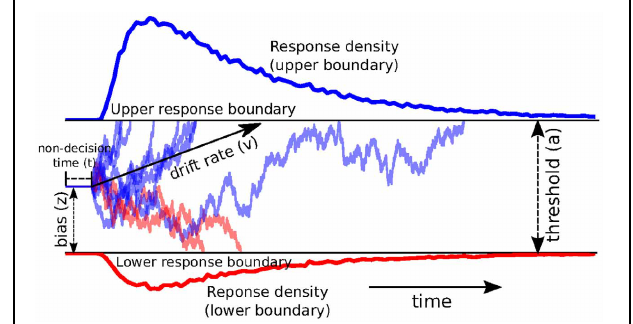
FIGURE 1 | Trajectories of multiple drift-processes (blue and red lines, middle panel). Evidence is noisily accumulated over time (x-axis) with average drift-rate v until one of two boundaries (separated by threshold a ) is crossed and a response is initiated. Upper (blue) and lower (red) panels contain density plots over boundary-crossing-times for two possible responses. The flat line in the beginning of the drift-processes denotes the non-decision time t where no accumulation happens. The histogram shapes match closely to those observed in response time measurements of research participants. Note that HDDM uses a closed-form likelihood function and not actual simulation as depicted